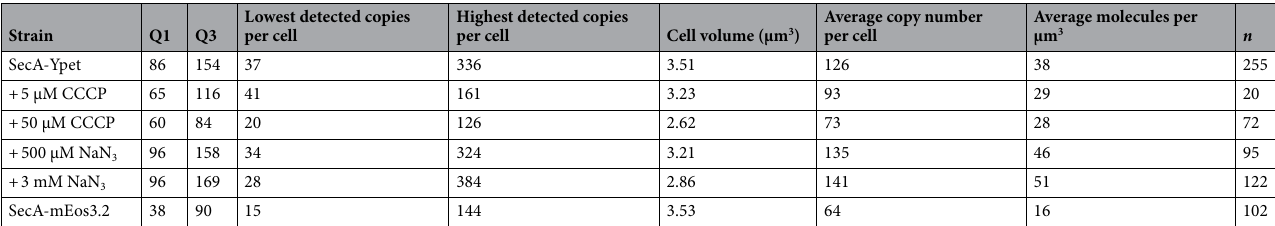
Table 1. SecA cellular copy number ranges under native and stressed